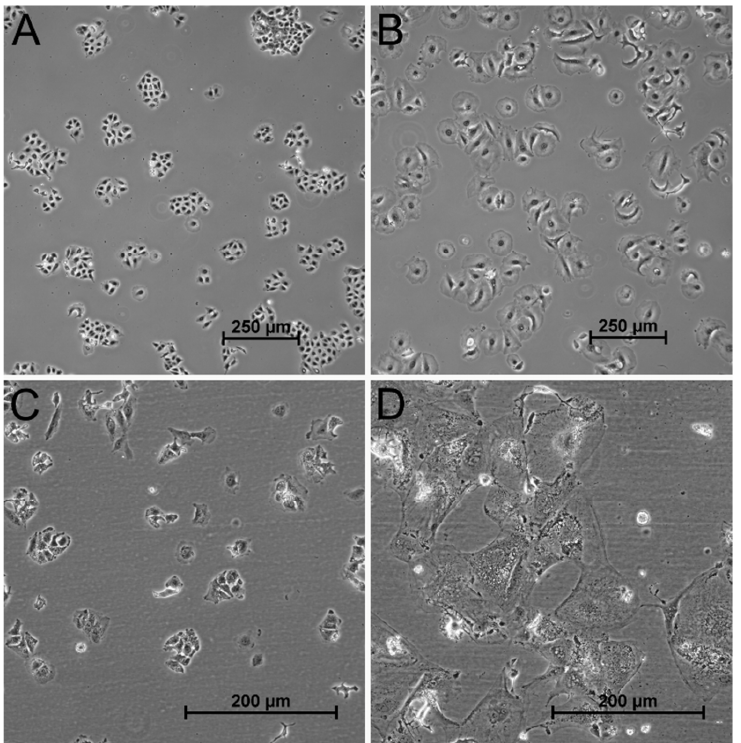
Figure 3. Cell morphology after 16 Gy gamma-irradiation. A549 ( A , B ) and HuH-7 ( C , D ) cells showed a pronounced increase in cell size after 16 Gy gamma-irradiation. Shown are representative images of untreated A549 cells ( A ) and HuH-7 cells ( C ) compared to cells six days after treatment with 16 Gy irradiation ( B : A549; D : HuH-7). Cells of both tumor cell lines were swollen after irradiation and showed the typical “fried egg”–morphology.